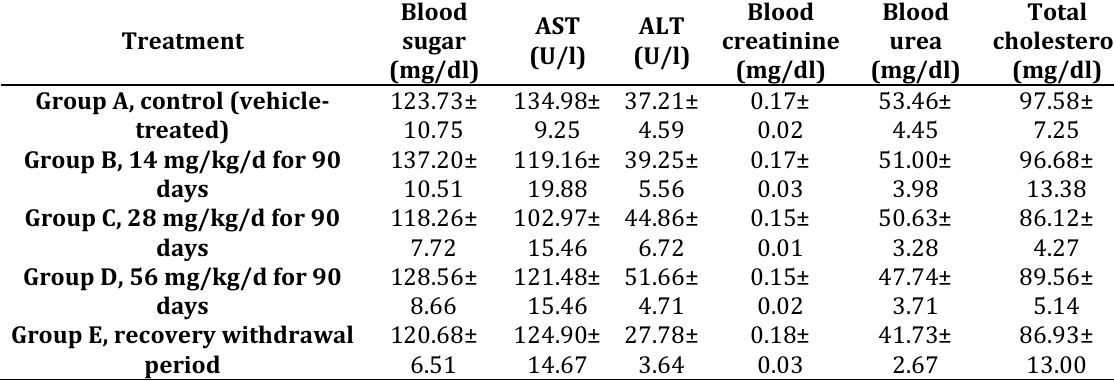
Table II. Biochemistry parameters of female mice after DPP administration (Utami,